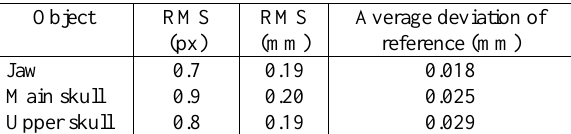
Table 4. Quality parameters of bundle adjustment.